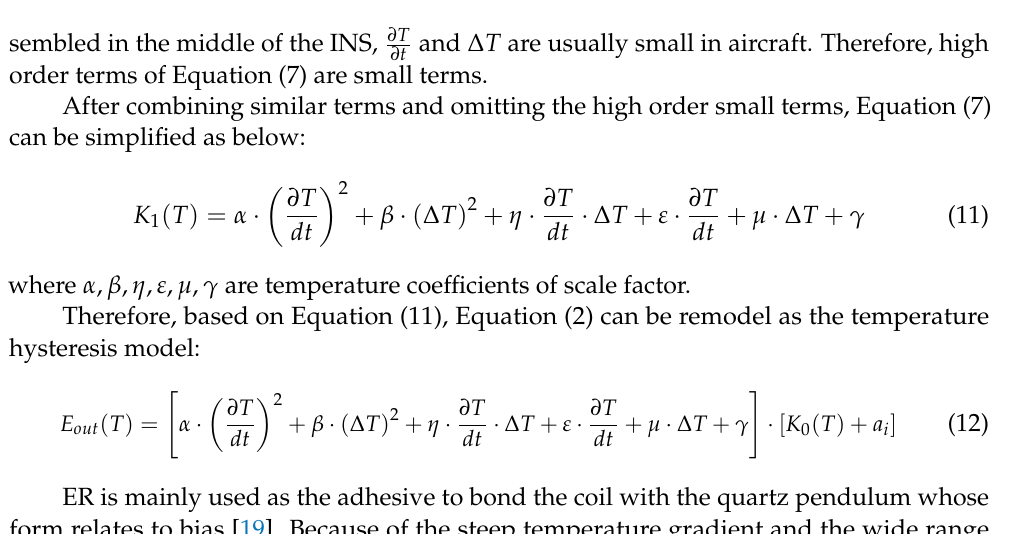
Table 2. Result s of creep deformation of ER.